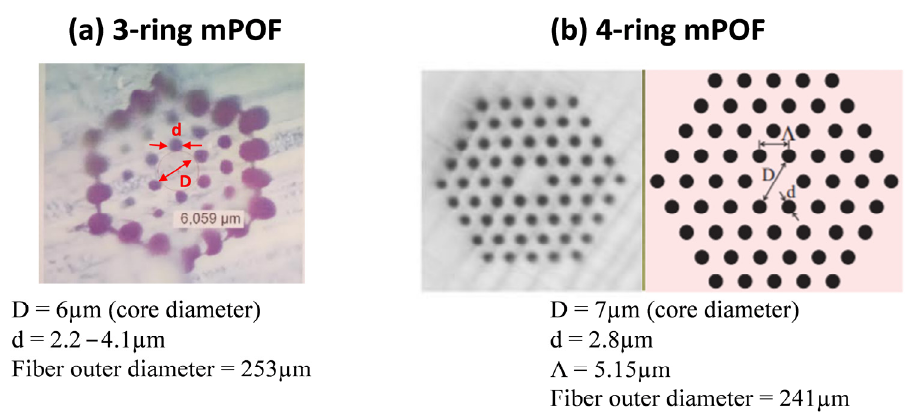
Figure 4. ( a ) Microscope image of the 3-ring hexagonal air hole distribution mPOF. ( b ) Microscope image and idealized target geometry for the 4-ring hexagonal air hole distribution mPOF. mPOF structural dimensions are provided.